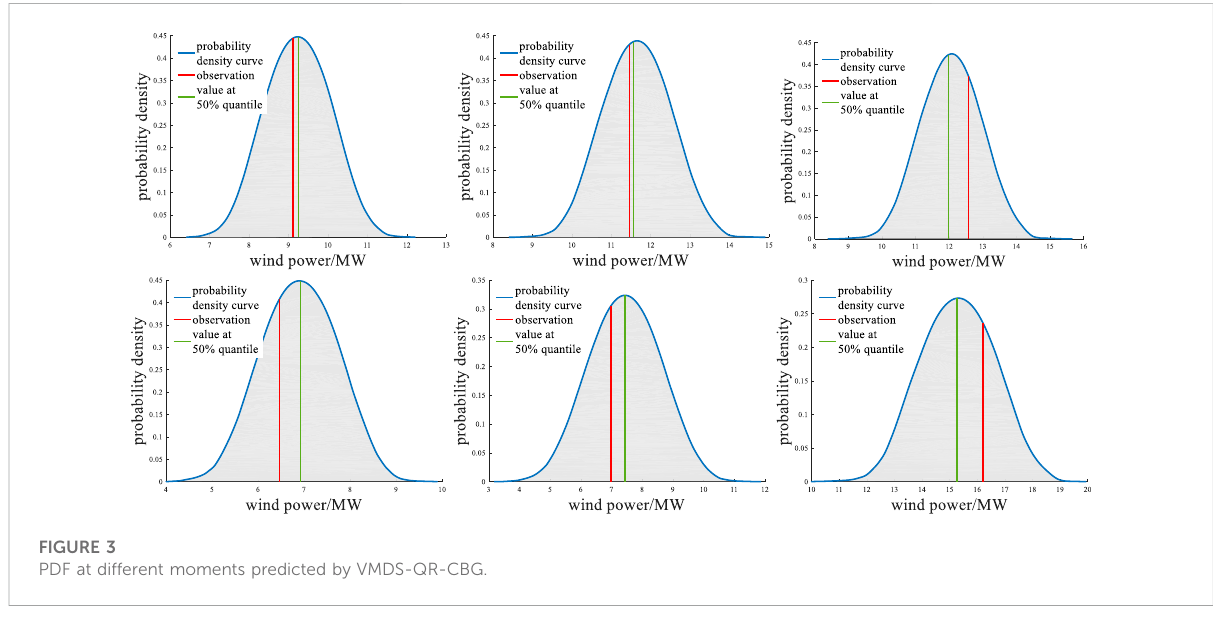
FIGURE 3 PDF at different moments predicted by VMDS-QR-CBG.